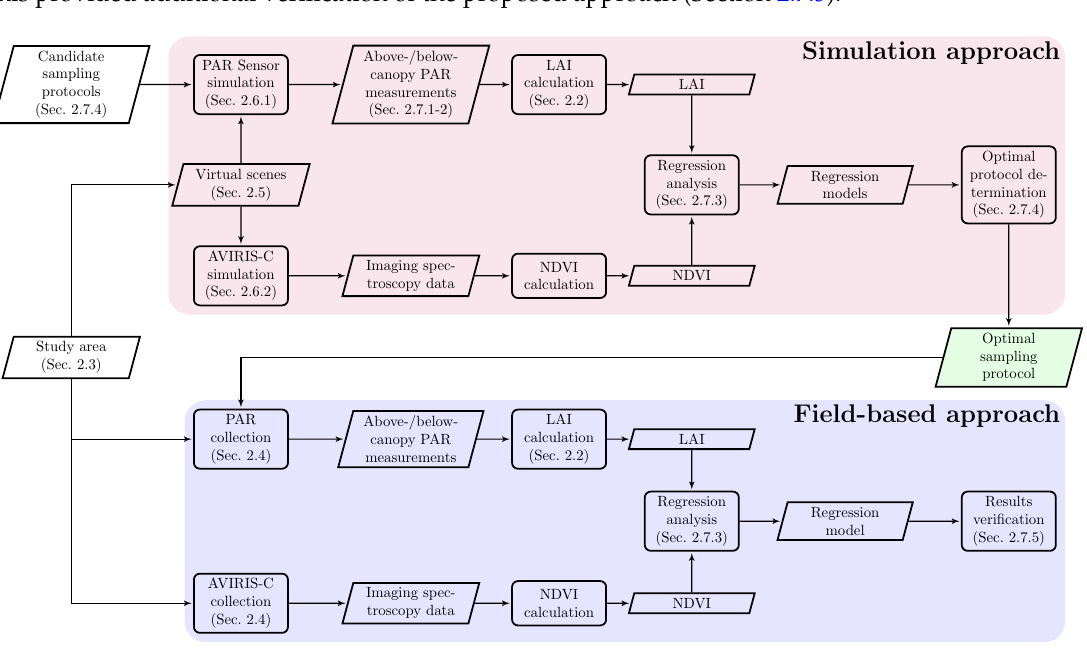
Figure 1. The study contains two parts: the simulation and field-based approach. Each step in the simulation environment is repeated in field-based approach to ensure that the simulations and models are